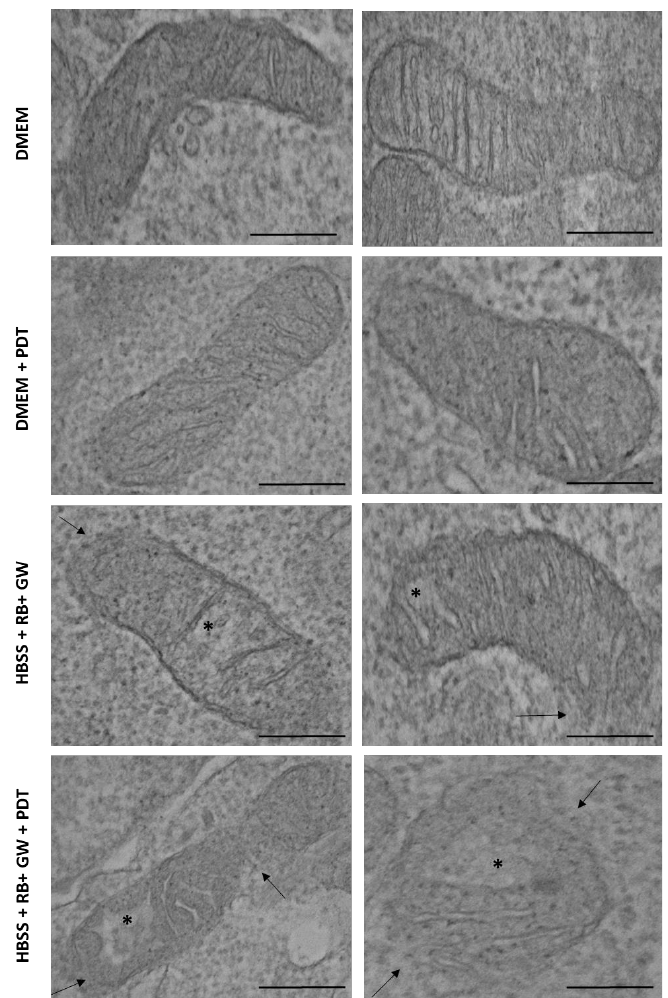
Figure 13. Ultrastructural analysis of mitochondria damage. T98G cells grown in standard DMEM high glucose medium, starved for 30 min in HBSS media, treated with RB (0.75 μ M) and GW4869 (GW = 5 μ M), and exposed or not to PDT (2 min at 562/576 nm) were then trypsinized and analyzed by TEM after 24 h p.t. Arrows indicated outer mitochondrial membranes damages while asterisks indicated a degradation of the integrity of mitochondria cristae. Scale bars (0.2 μ m) are reported.